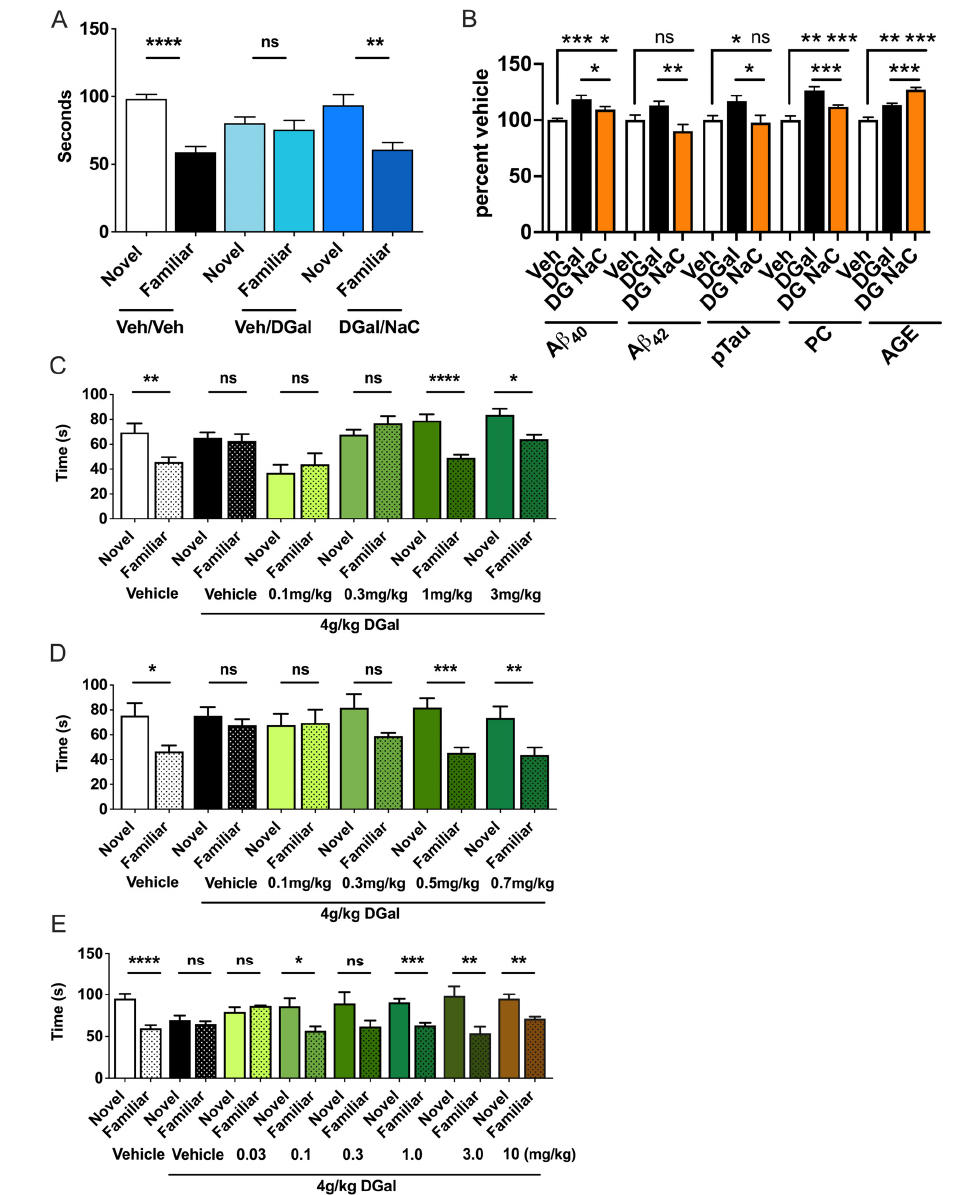
Figure 7. Spatial cognitive deficit and pathology are reversed or delayed pharmacologically. ( A ) SRT is represented as exploration time, in seconds, of familiar and novel locations. Animals were dosed chronically with vehicle or 4 g/kgoDGal with and without 5g/kg NaC for 5 weeks. Data are analyzed by unpaired t -test. ( B ) Representation of A β 40 , A β 42 , p-Tau, PC, and AGE detected in the soluble hippocampal fraction from animals dosed chronically over 5 weeks with vehicle (Veh) or 4